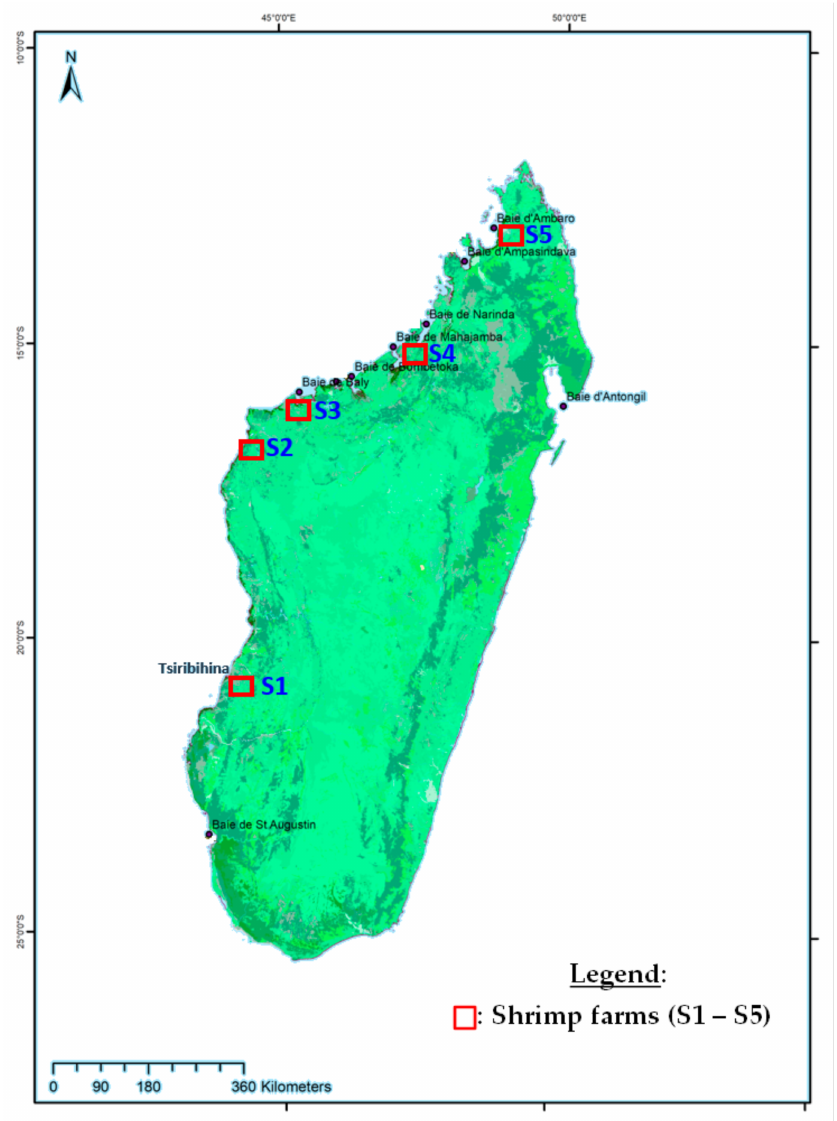
Figure 1. Sampling sites for crustaceans during the study. The Shrimp farms are located in Belo sur Tsiribihina ( S1 ), Sambao estuary ( S2 ), Baly bay ( S3 ), Mahajamba bay ( S4 ) and Ambaro bay ( S5 ). Primers 146F2 and 146R2 (Table 1) were used for nested (2 step) PCR to amplify